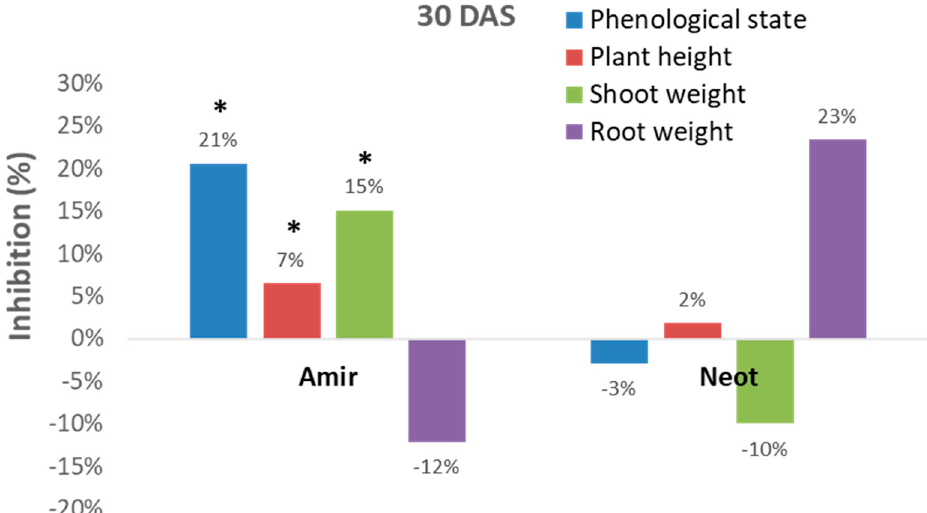
Figure 3. Soil bioassay using Megaton cv. as a testing plant. The late-wilt-sensitive maize Megaton cv. was sown in two commercial soils that have a long history of late wilt disease—the Kibbutz Amir field and the Kibbutz Neot Mordechai field (both located in the Hula Valley, Upper Galilee, northern Israel). The experiment was conducted in six replications in pots in a growth chamber under controlled conditions. The plants’ growth parameters were evaluated 30 DAS. Values represent the average difference (% inhibition) of the plants that grew on naturally infested soil, compared to the control. Control group comprises maize plants grown on soil taken from a field nearby, that has minor levels of M. maydis infestation. Weight—wet biomass. Vertical upper bars signify the standard error of the mean of six repeats (pots, each having five plants). Significance difference from the control is shown as * = p < 0.05.